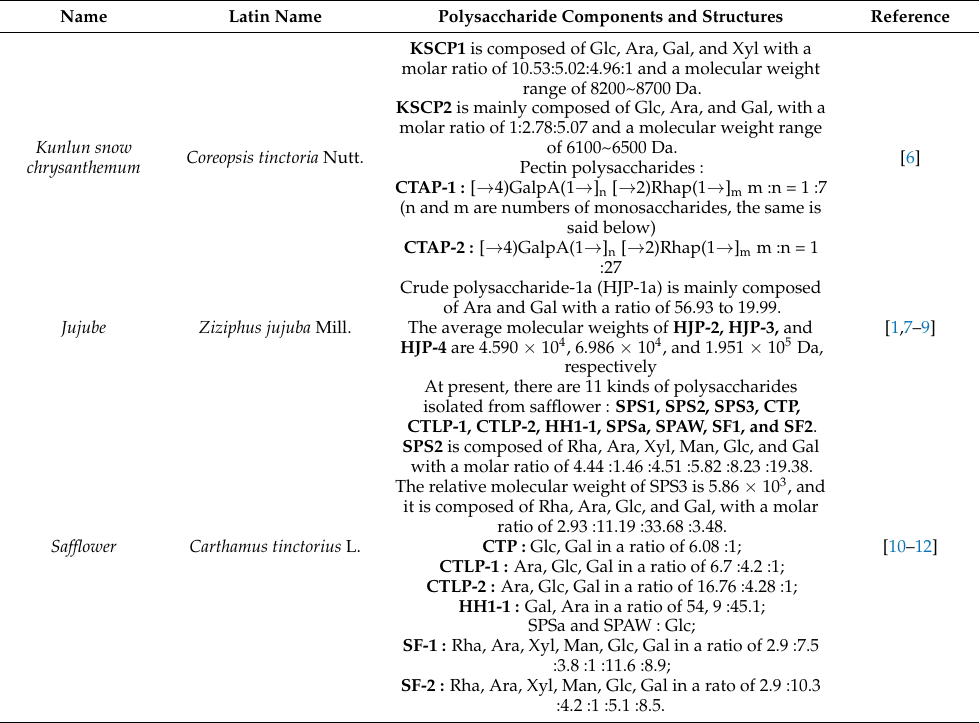
Table 1. Monosaccharide components in polysaccharides from some medicinal and edible plants grown in